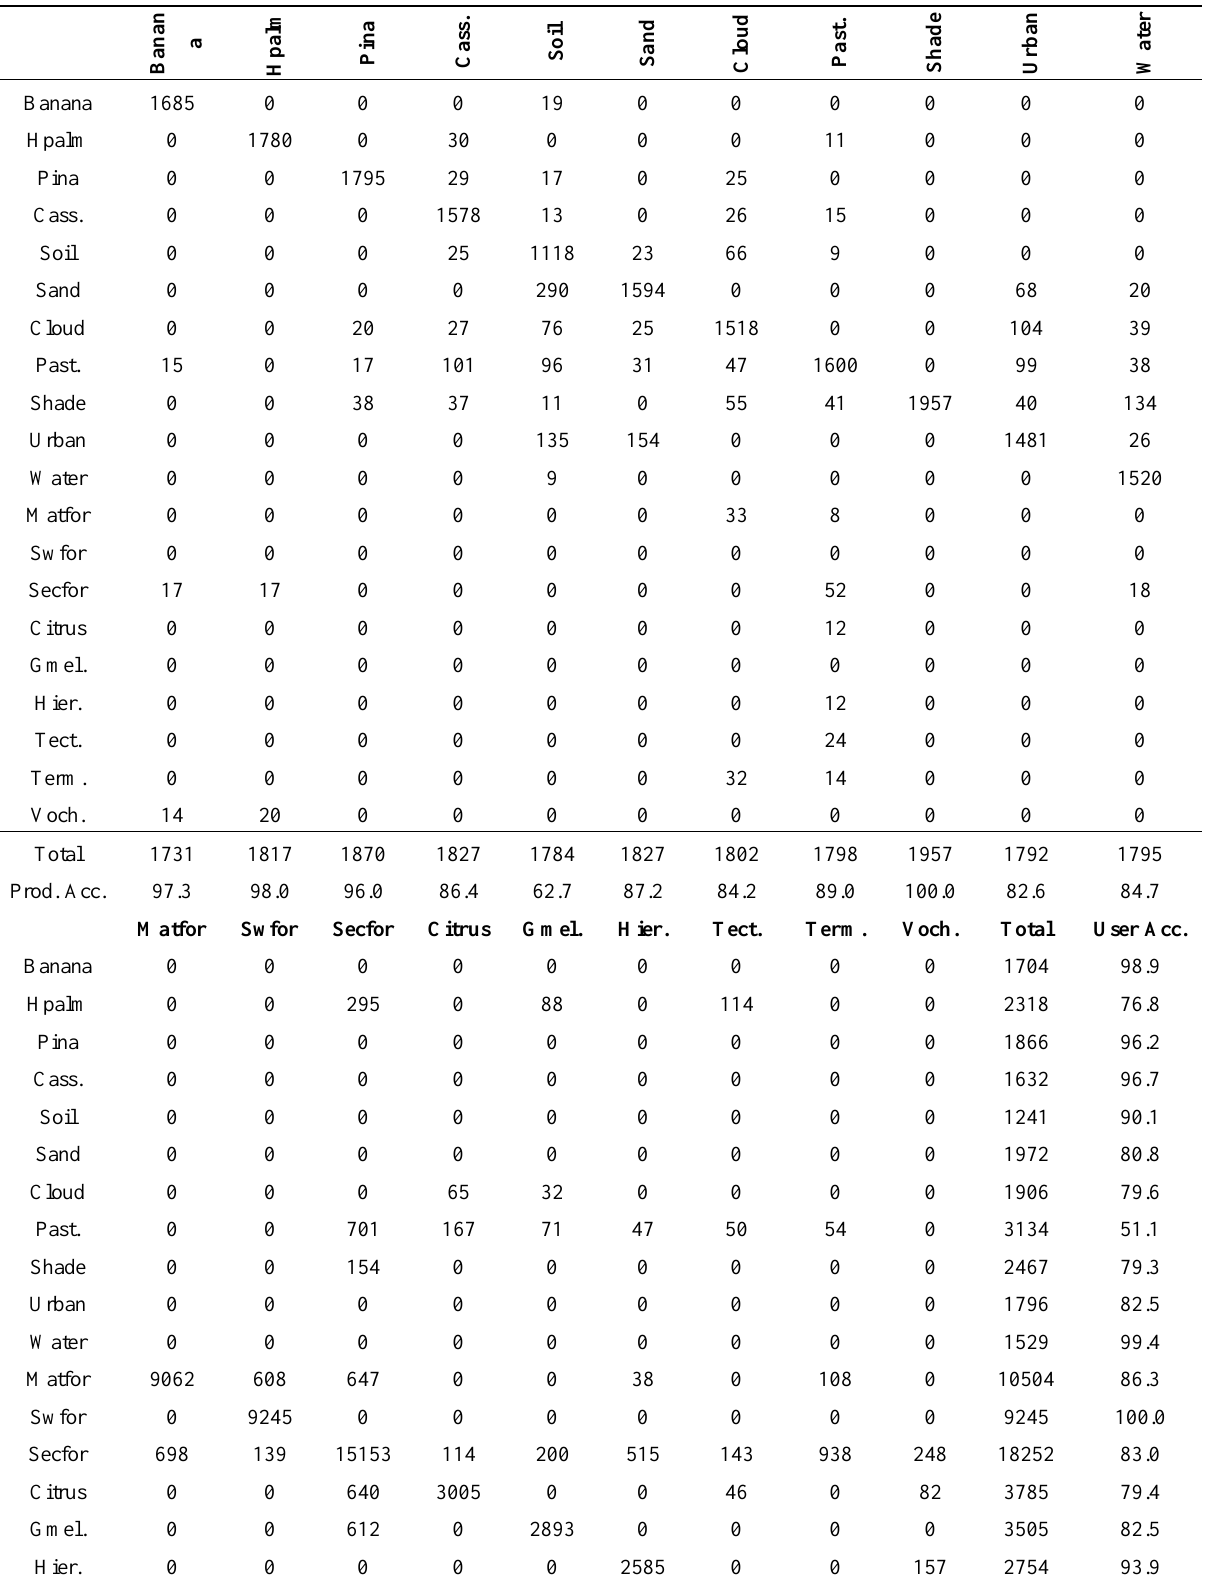
Table A3. Bootstrapped accuracy confusion matrix for the HyperLsLC map in Figure 8. We show here the four summary classes disambiguated into their component classes, with producer’s and user’s accuracies estimated directly from the